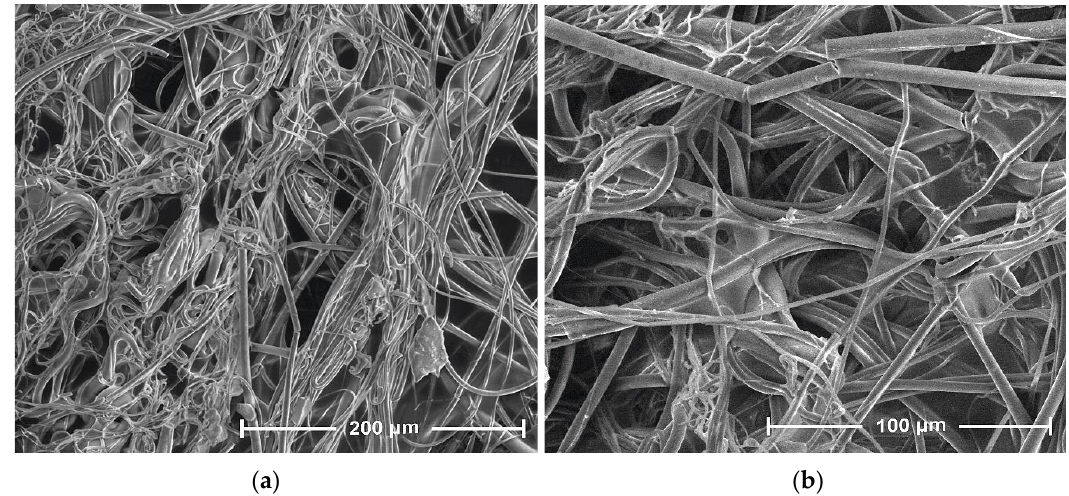
Figure 5. SEM images of PLA-ALG-Na (+) , magnification: ( a ) 800× and ( b ) 1600×.